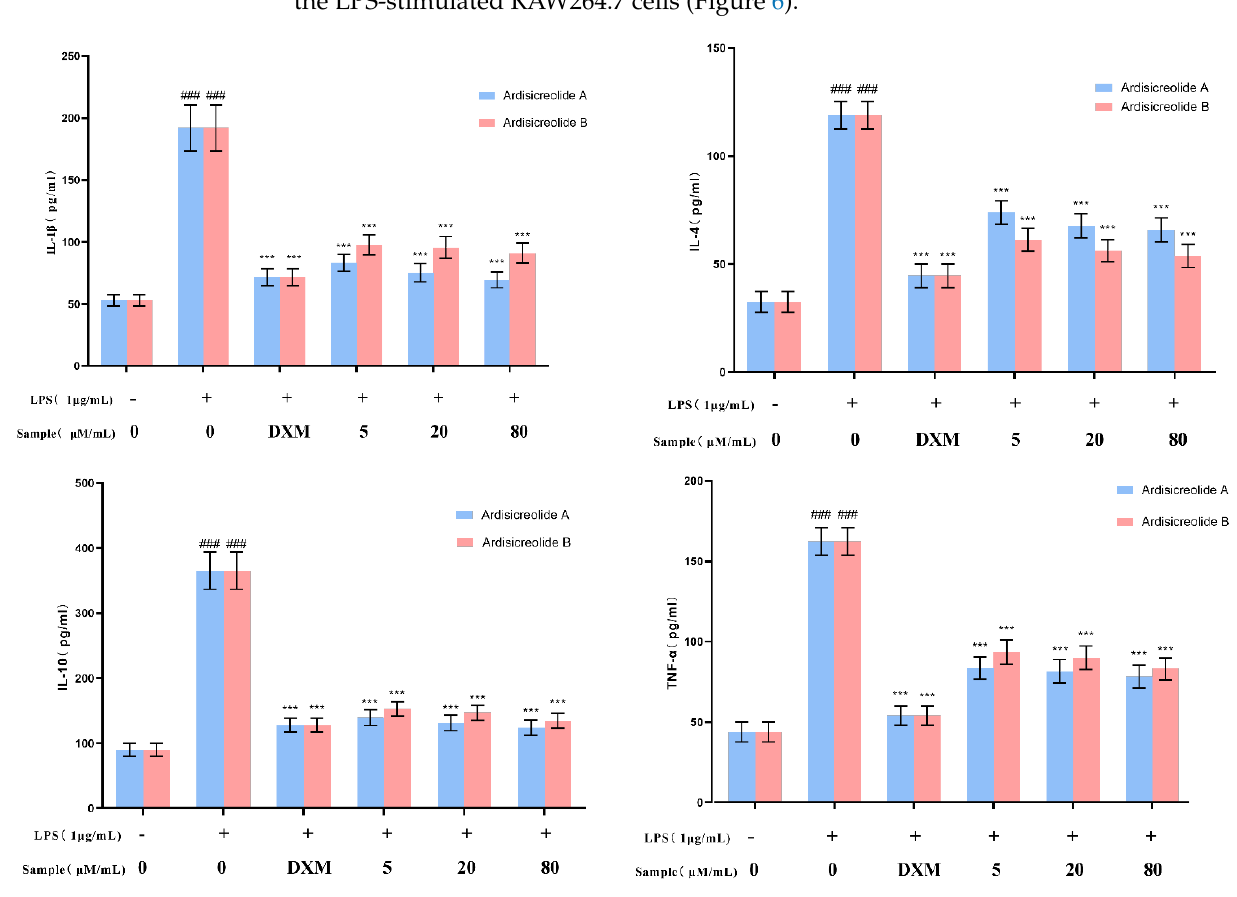
Figure 6. Ardisicreolides A and B decreased the inflammatory cytokine production. Dexamethasone with 40 μg/ mL was used as the positive control. The data were expressed as the mean ± SD ( n = 3). *** p < 0.001 compared to the model cells that were treated by LPS. ### p < 0.001 versus the control.